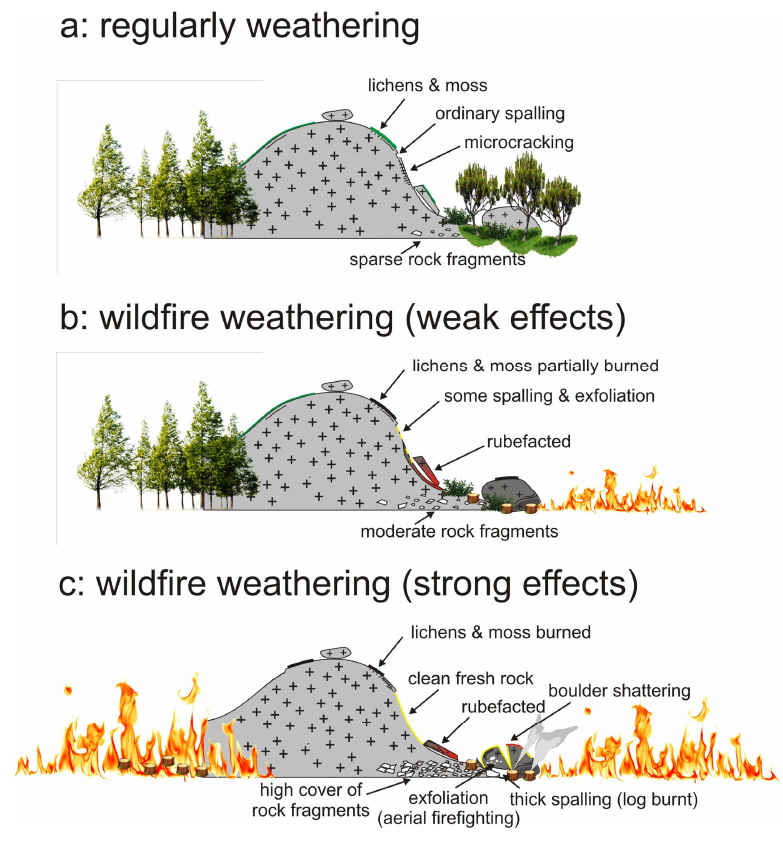
Figure 15. Surface mechanical effects of wildfires on rocks in the climbing areas: ( a ) ordinary situation with current weathering; ( b ) changes in bedrock by weak wildfire partially affecting an area; ( c ) strong effects of a wildfire on a bedrock